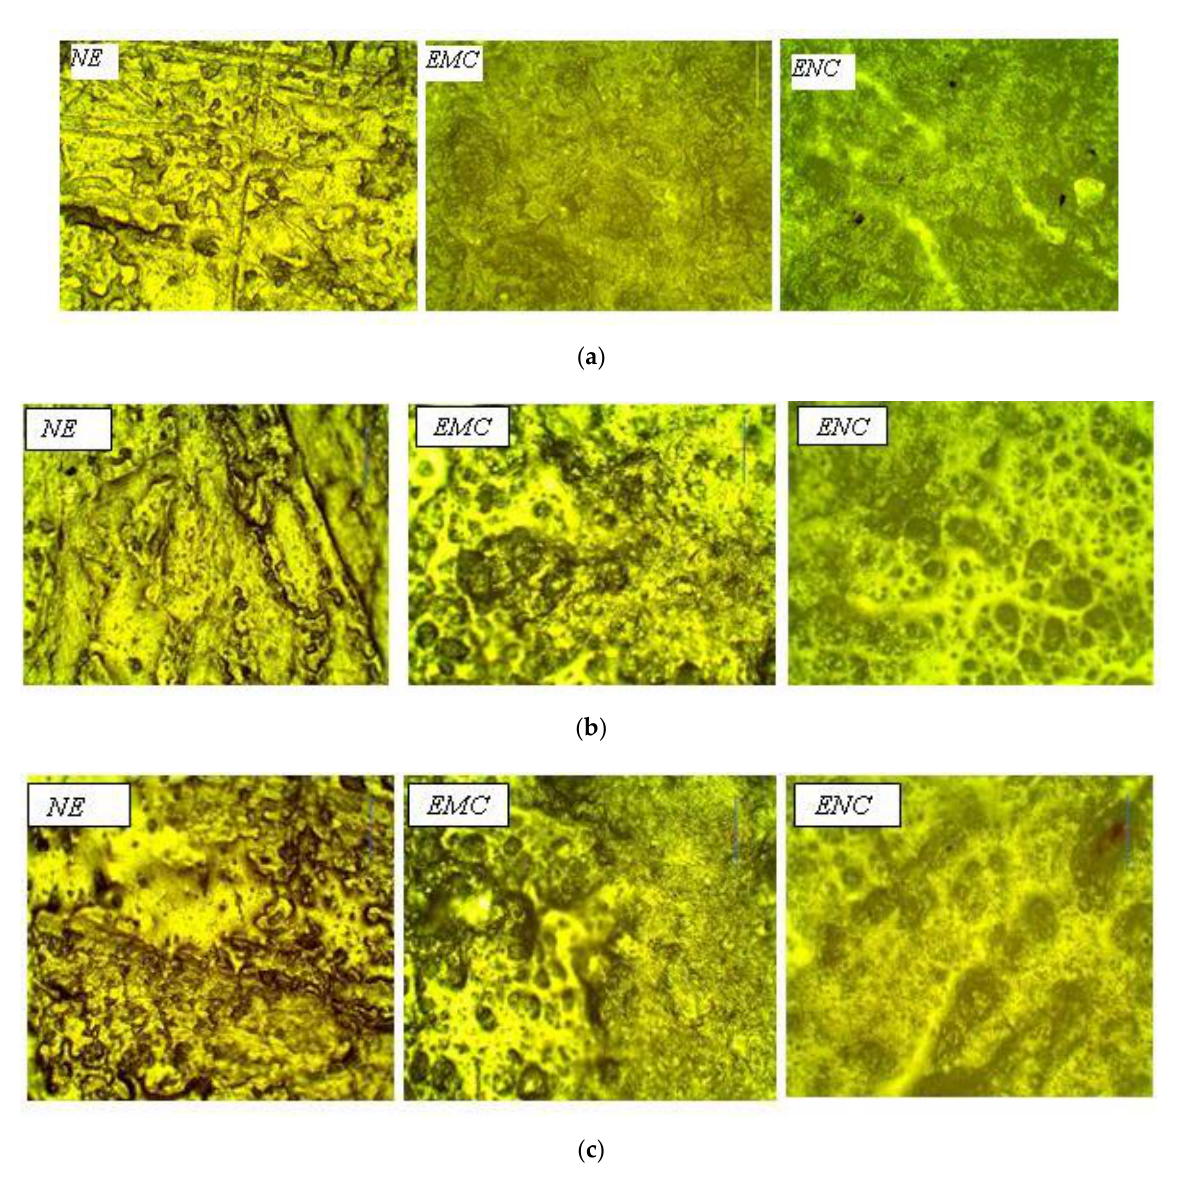
Figure 8. ( a ) Optical microscopy images of unaged samples. ( b ) Optical microscopy images of 30 hrs aged samples. ( c ) Optical microscopy images of 60 h aged samples.